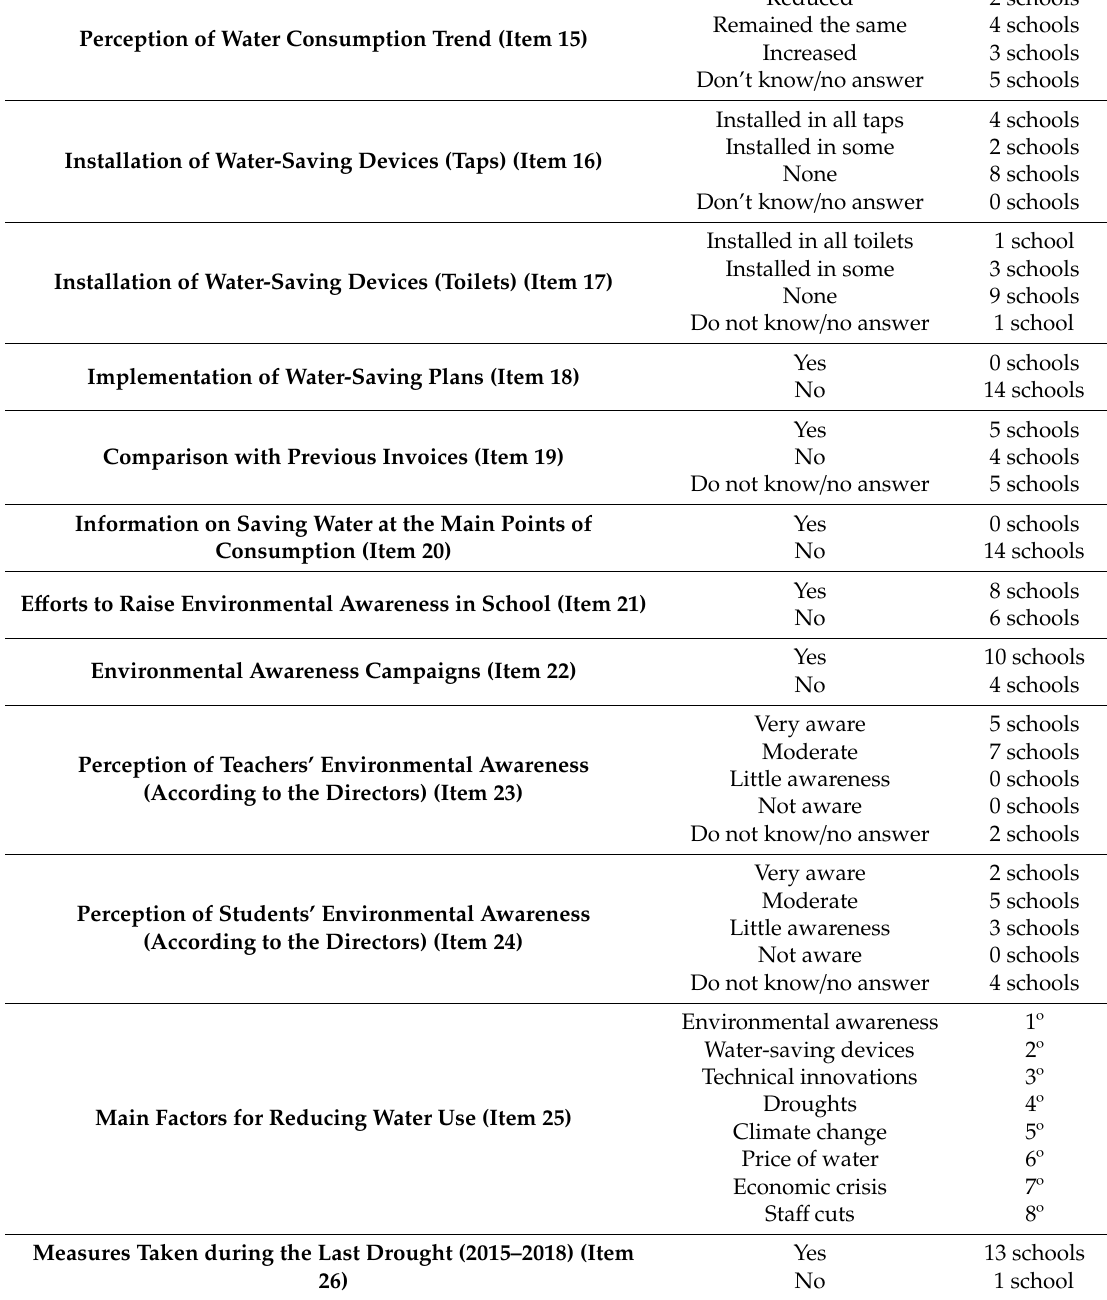
Perception of Water Consumption Trend (Item 15)